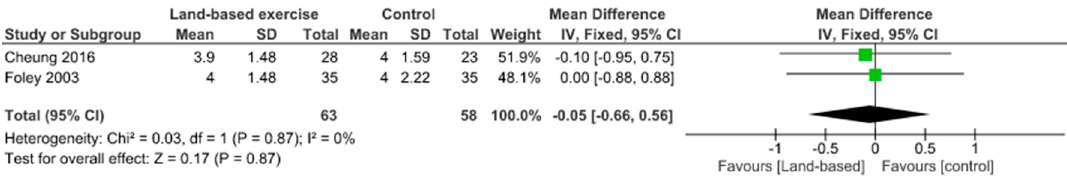
Figure 15. Sti ff ness: Aquatic exercise versus Control.